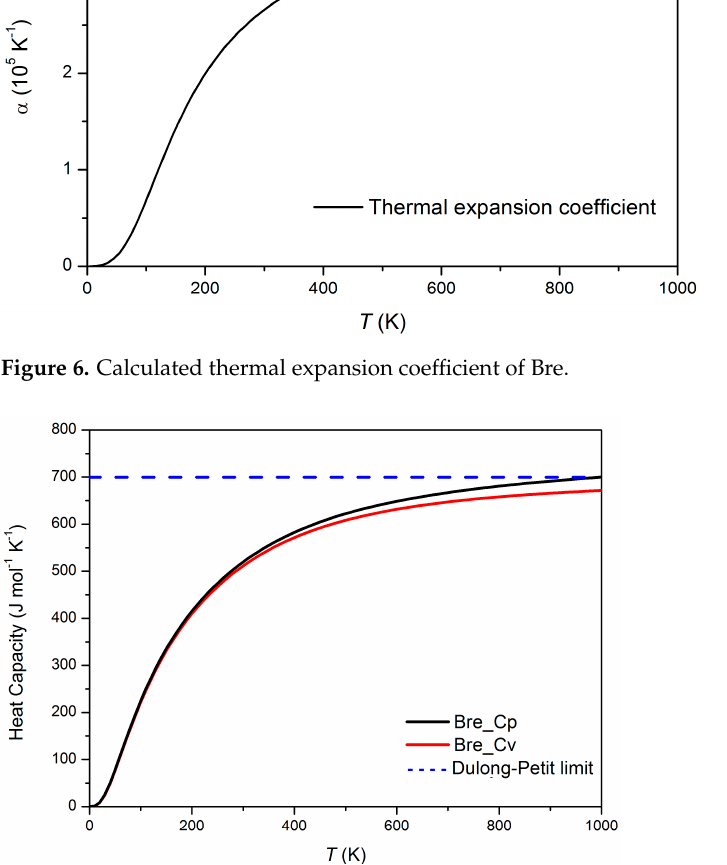
Figure 7. Isobaric and isochoric heat capacity ( C p and C v , respectively) of Ca 7 MgSi 4 O 16 -Bre. Note that the C v values remain lower than the harmonic limit of Dulong–Petit (3 R /M, with R as the gas constant and M as the molar mass) for T less than 1000 K, suggesting that either the quantum effects for the ionic vibrations remain noticeable for this T range, or our C v values have been slightly underestimated (presumably by a few percent) because the volume used in the calculation is for zero P and zero T